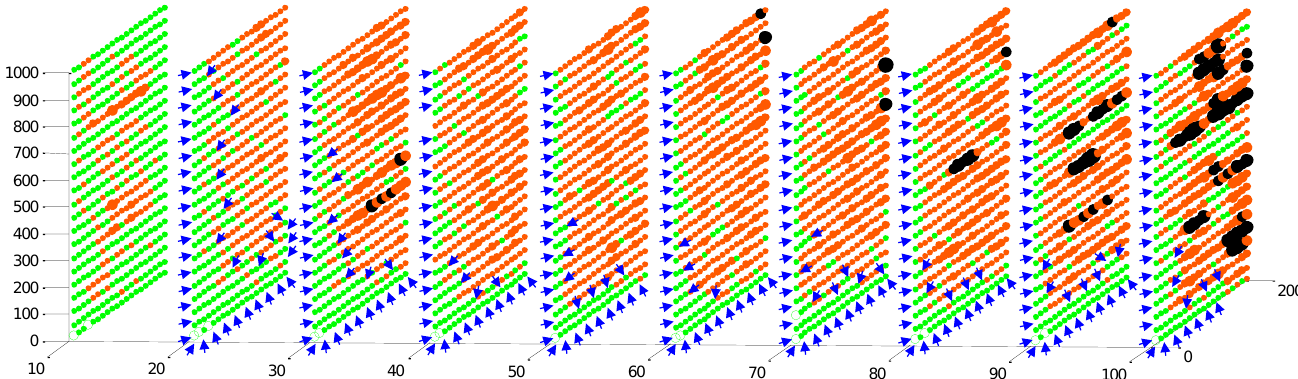
Fig. 10. “Angle bars” of poor filter numbers by performance